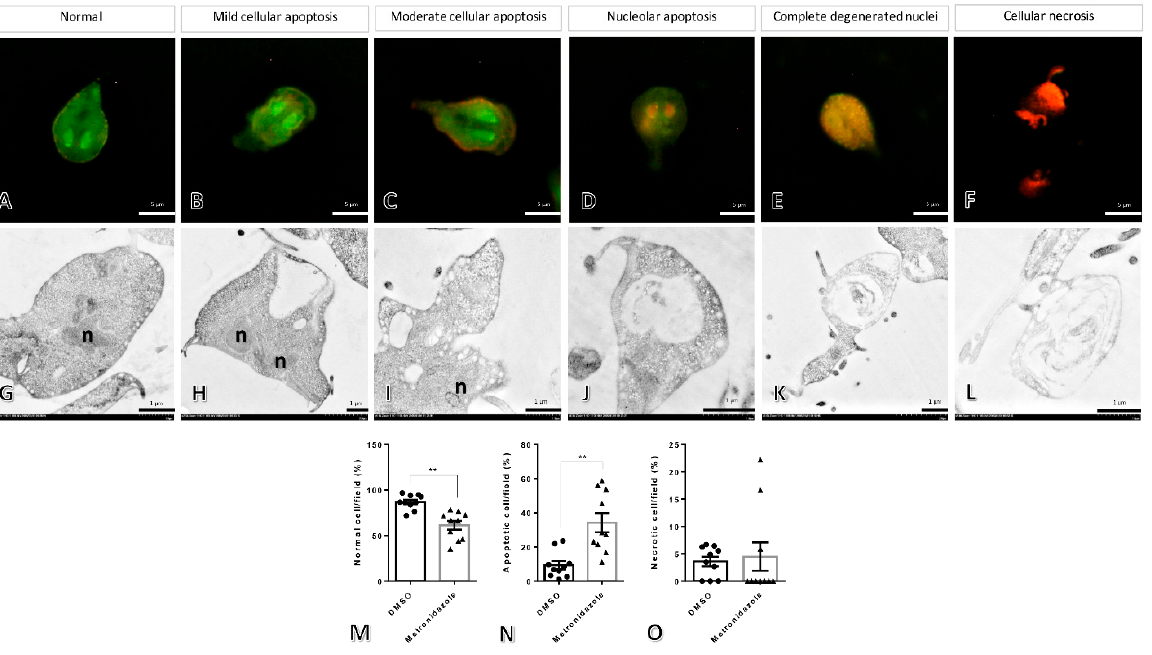
Figure 2. The morphological and ultrastructural changes in Giardia after treatment with metronidazole and 0.25% dimethyl sulfoxide . The different stages of the parasite were characterized by acridine orange/ethidium bromide staining ( A – F ), normal cells with whole green cytoplasm and nucleus ( A ), mild to moderate cellular apoptosis with diffused increasing orange in the cytoplasm ( B , C , respectively), nucleolar apoptosis to complete degenerative nuclei with orange nuclei until the entire cell is orange colored ( D , E , respectively), and necrosis with red cells ( F ). Ultrastructural changes in the parasite were demonstrated by electron microscopic study ( G – L ), intact cell ( G ), vacuolated degeneration ranging by low, moderate, and high severities and loss of normal cellular architecture ( H – K ), and complete loss of normal cellular components ( L ), the bar graphs comparing the number of normal, apoptosis, and necrosis cells in any treatment ( M – O ). n: nucleus, **: p -value < 0.01.